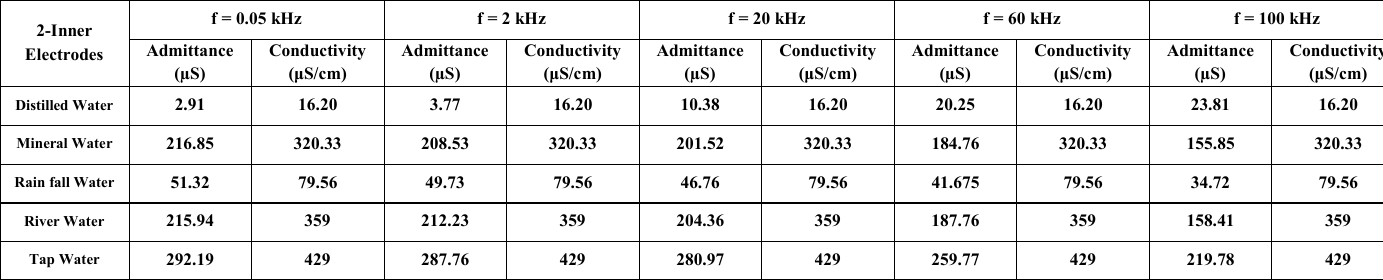
Table (2): Calculated values of admittance and measured conductivity for different frequencies by the two-inner electrode system